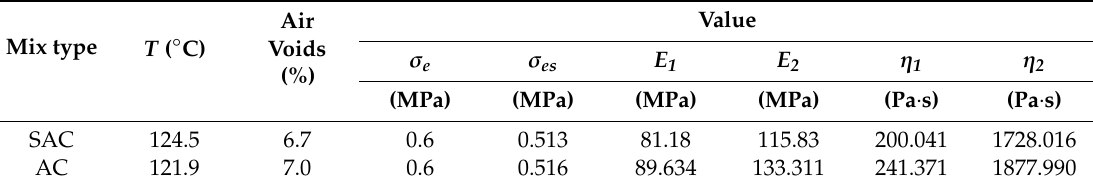
Table 6. Parameters of the 15th load cycle.